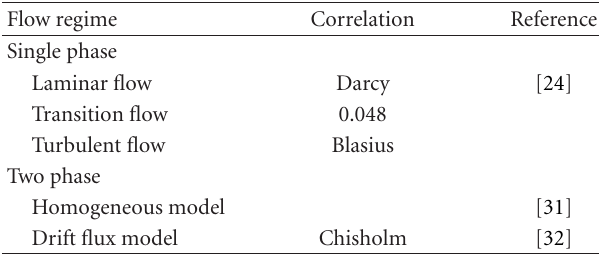
Table 2: Frictional coe ffi cient correlations. Table 3: Main parameters of SG and